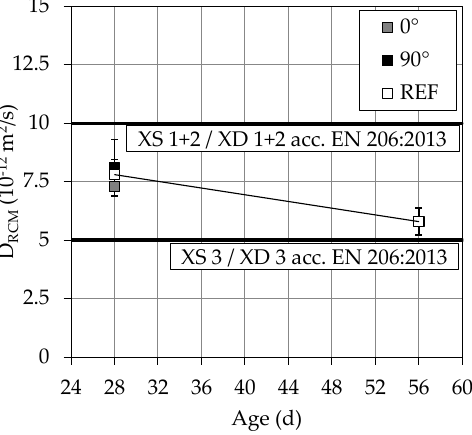
Figure 14. Chloride migration coefficient D RCM .